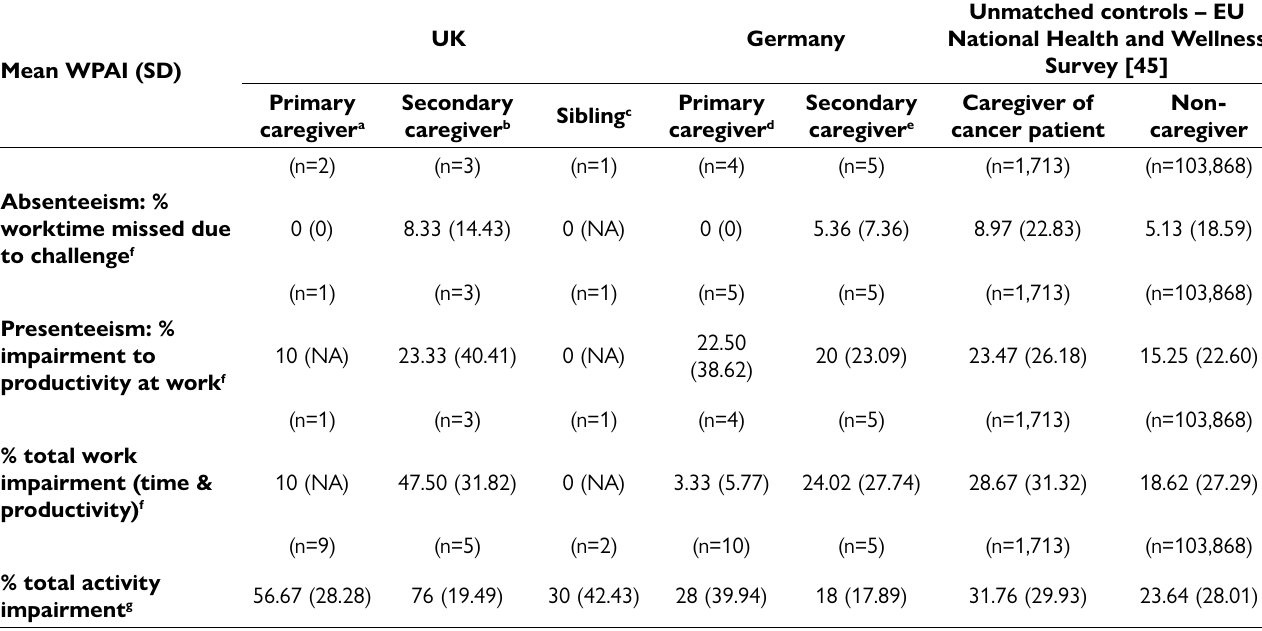
Table 9. Work Productivity and Activity Impairment (WPAI) by caring role (including adult siblings) UK Mean WPAI (SD)